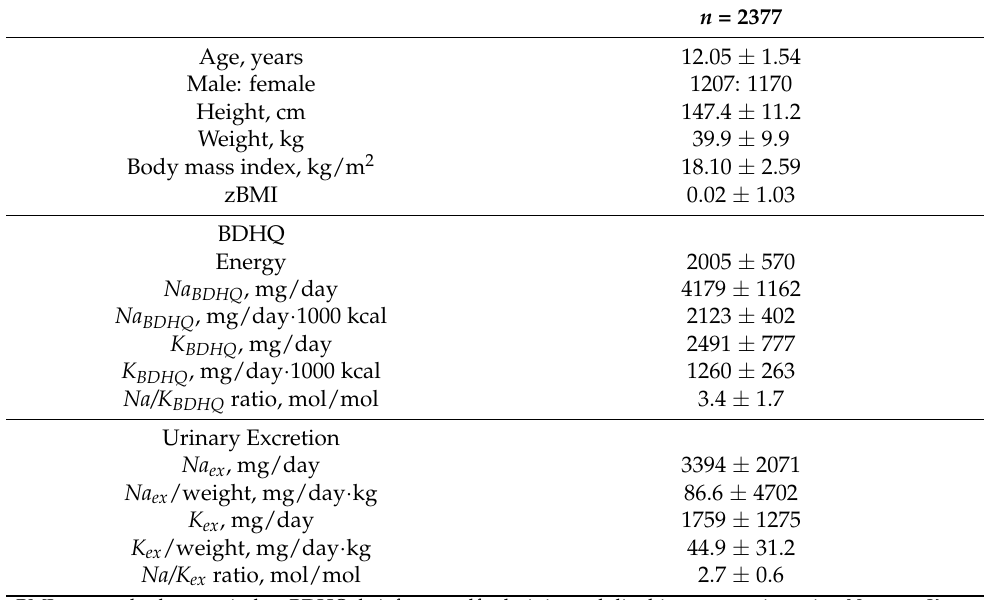
Table 2. Characteristics of the subjects.